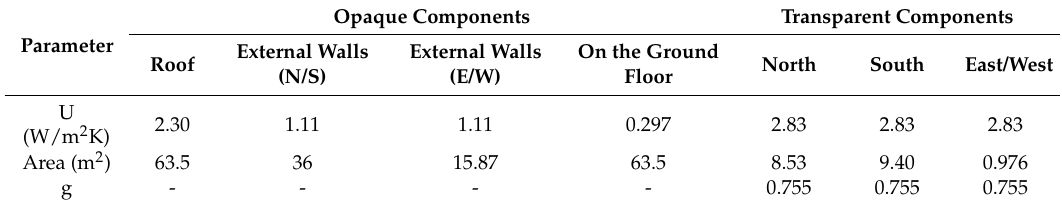
Table 2. Building characteristics.